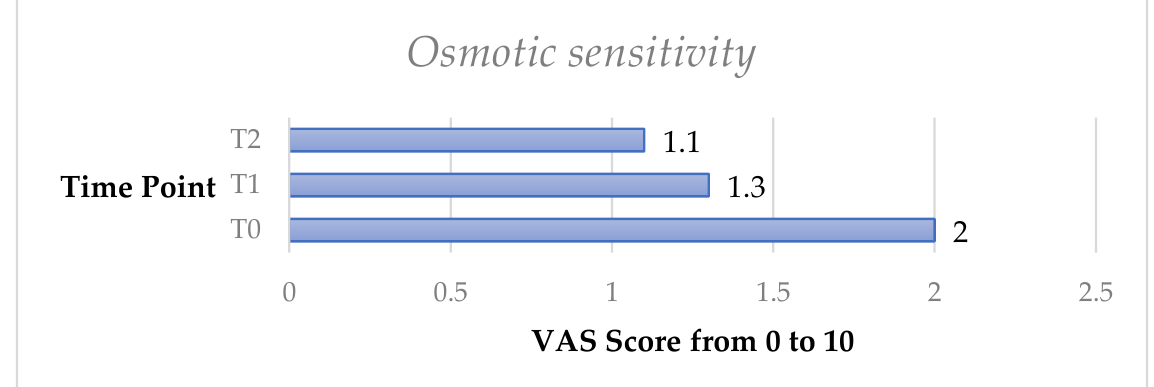
Figure 7. Mean values of acid sensitivity test trend from T0 to T2 in the whole sample.